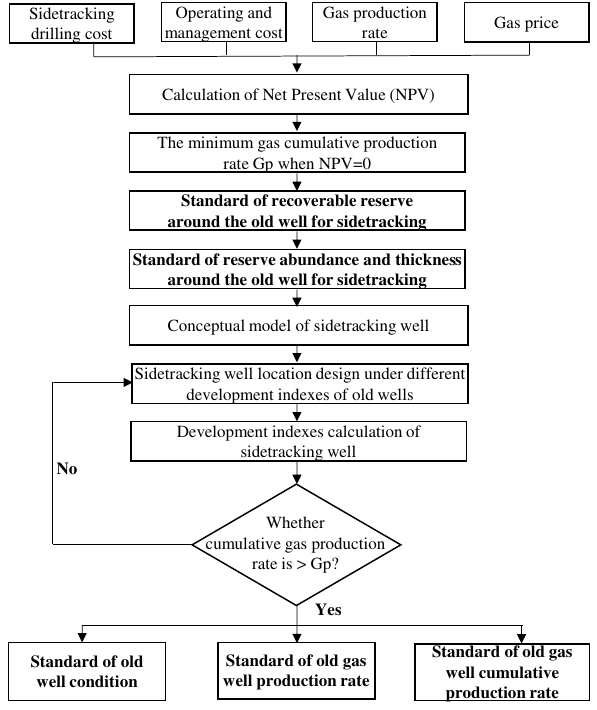
Fig. 1 Method and flowchart of establishing sidetracking well selec- tion